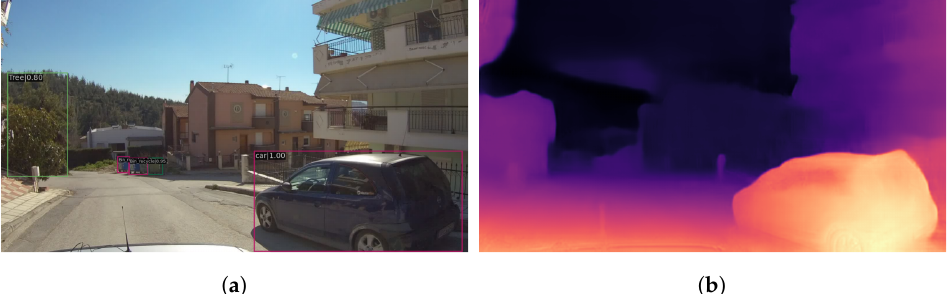
Figure 2. Example of object position estimation pipeline. ( a ) Object detection. ( b ) Depth